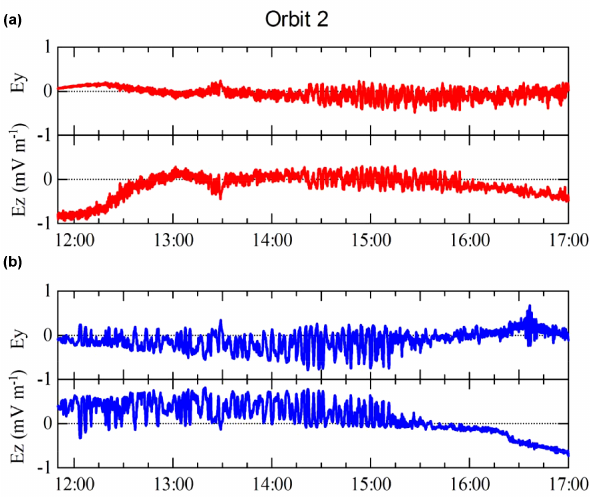
Figure 9. Van Allen Probes A (plotted in red) and B (plotted in blue) observations of electric field from 11:50 to 17:00UT on 1 May 2014. The electric field pulsations were indeed observed during the second orbit (larger at Van Allen Probe B) though the magnetic field pulsations were absent. We suggest that the spacecraft were near a magnetic field null when at the appropriate local times on this orbit.